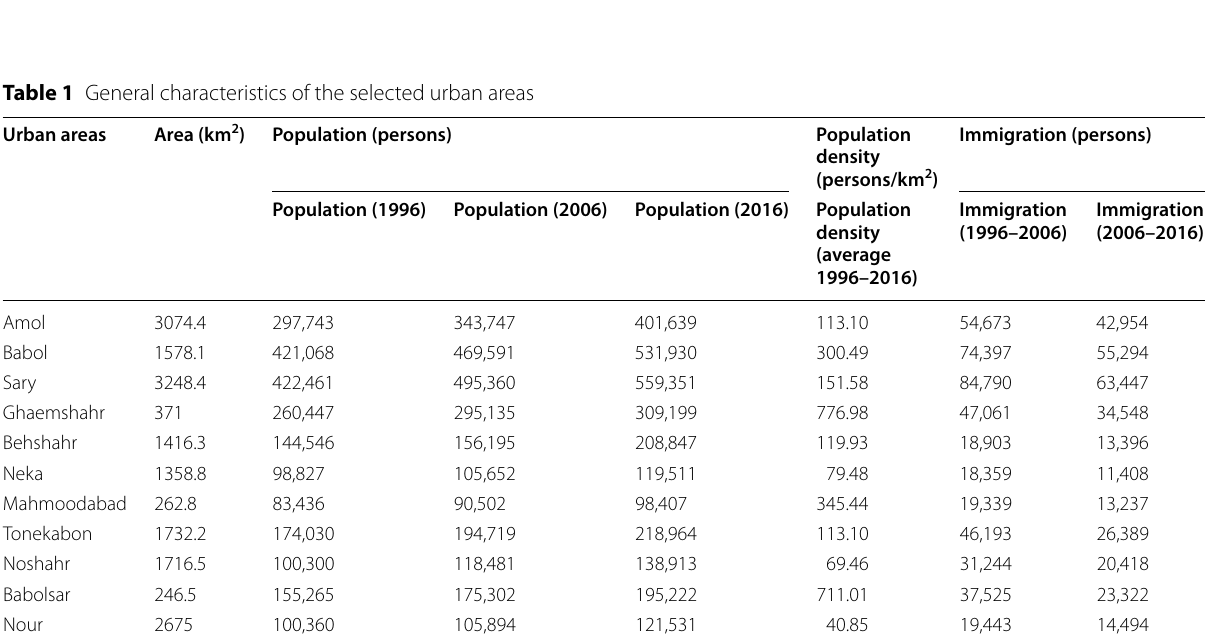
Source: Statistics Centre of Iran